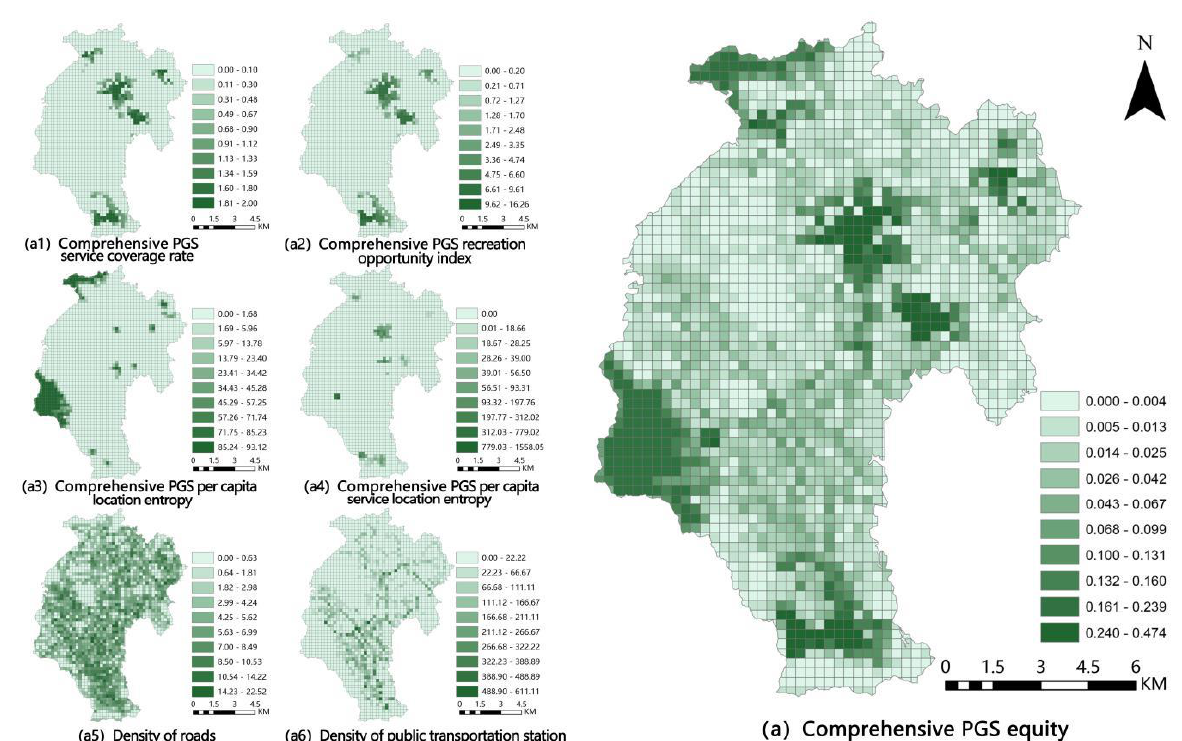
Figure 5. Equity indexes of comprehensive PGS.